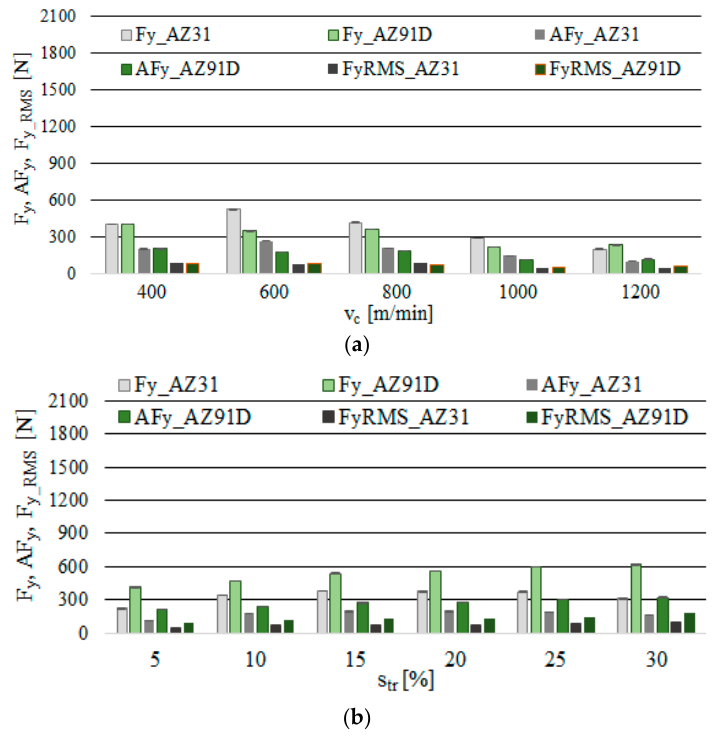
Figure 6. E ff ect of cutting speed and trochoidal step on cutting force component F y in milling of magnesium alloys: ( a ) v c (f z = 0.15 mm / tooth, a p = 6 mm, s tr = 15%) and ( b ) s tr (v c = 800 m / min, f z = 0.15 mm / tooth, a p = 6 mm).